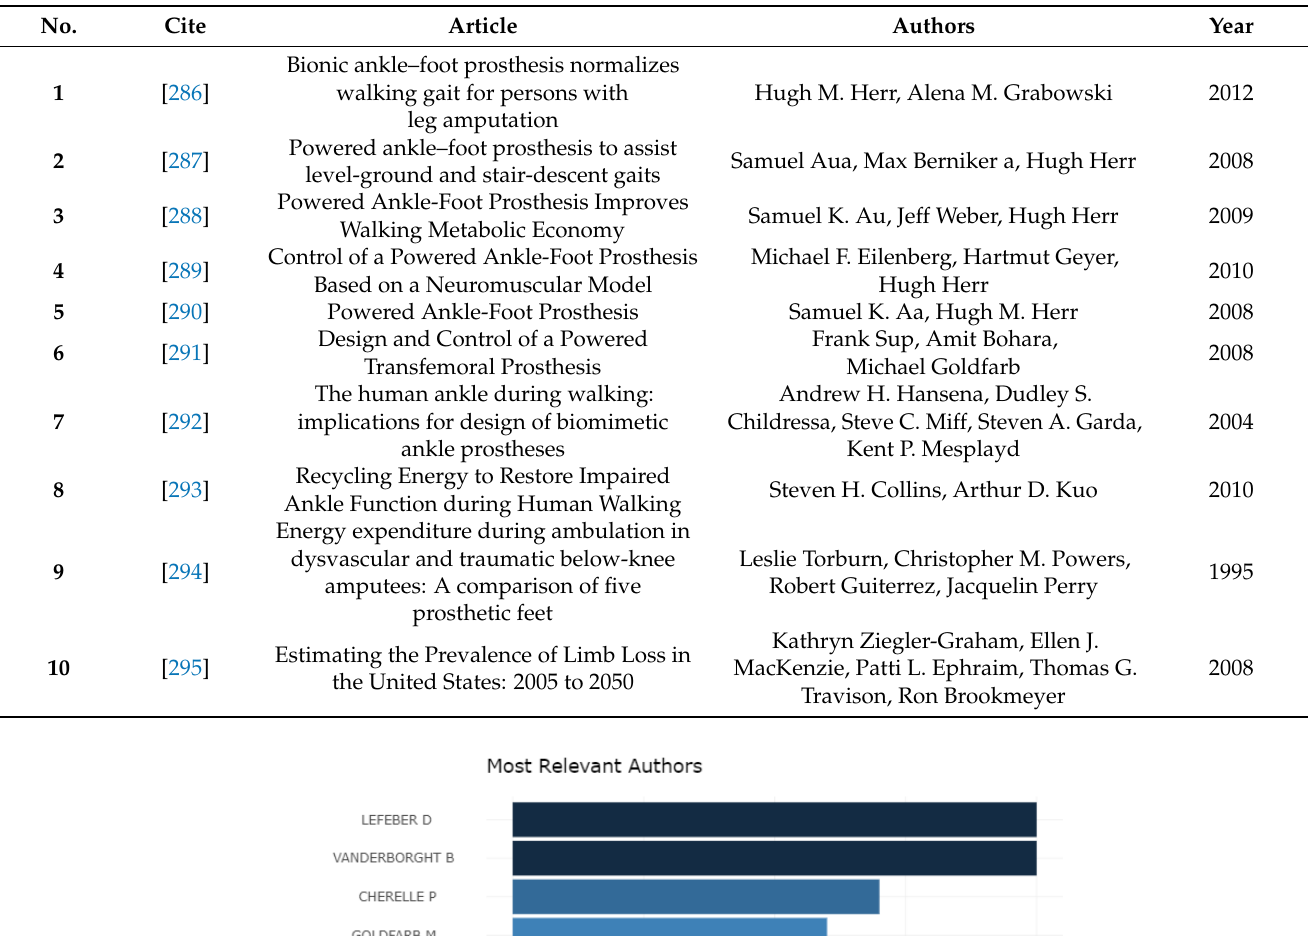
Table 3. Top 10 most cited articles in ankle/foot prosthesis.